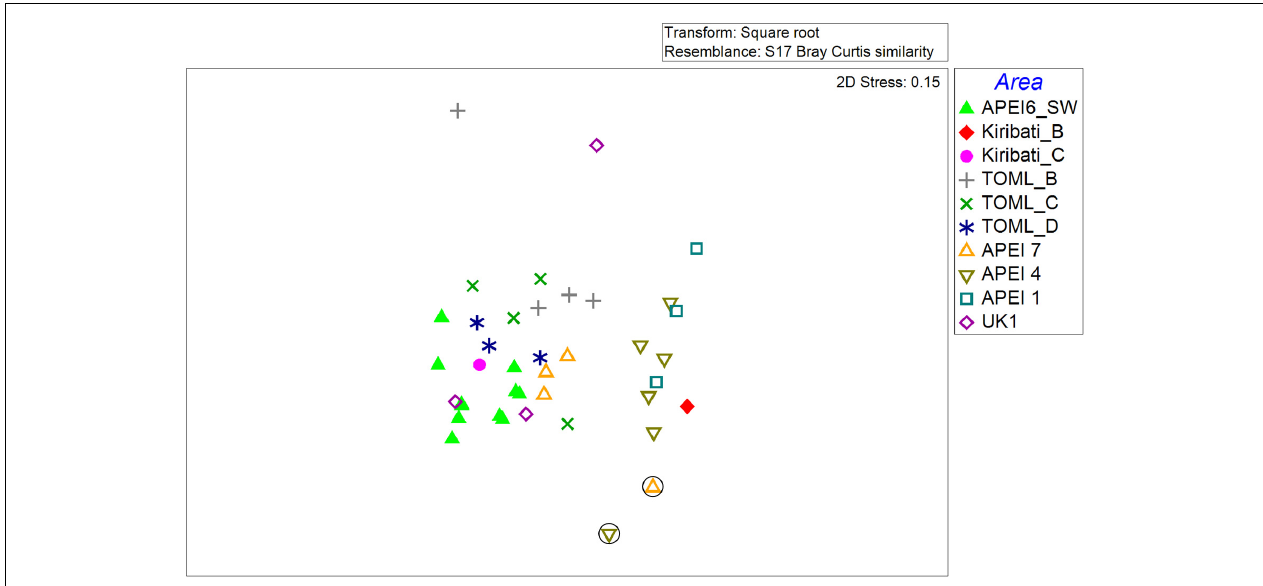
FIGURE 5 | MDS plot of fish community composition based on a square root transformed Bray-Curtis similarity matrix of fish densities for each quantitative transect in each area across the CCZ. Circled symbols represent transects on abyssal seamounts.